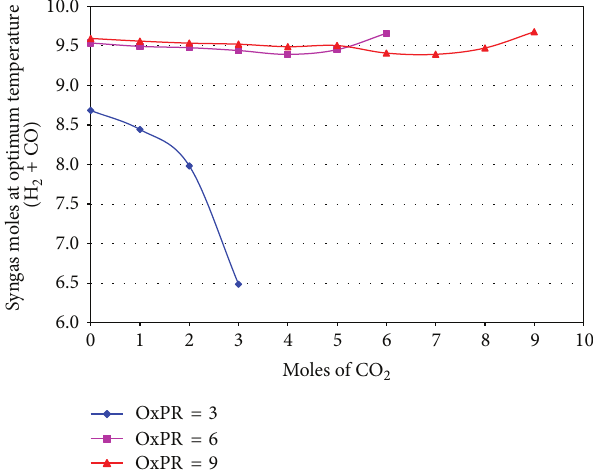
Figure 5: Optimum temperatures in CR of propane.